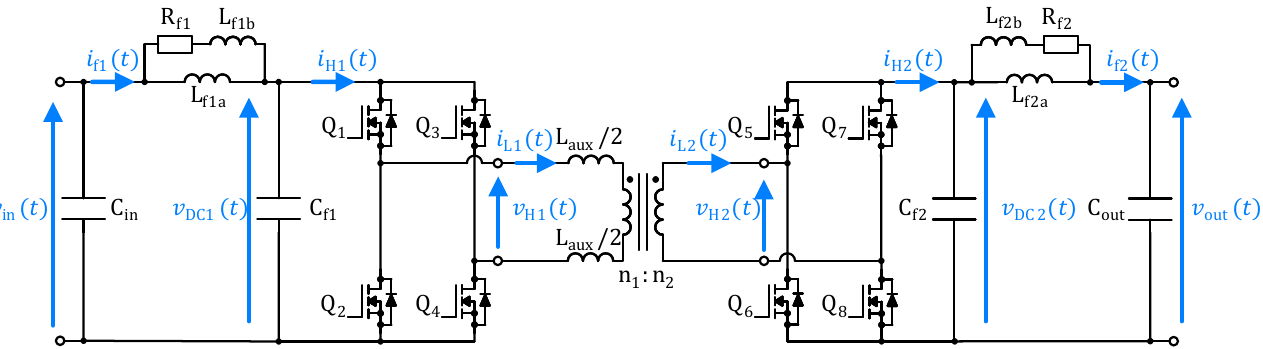
Figure 1. Schematic of the DAB converter with current